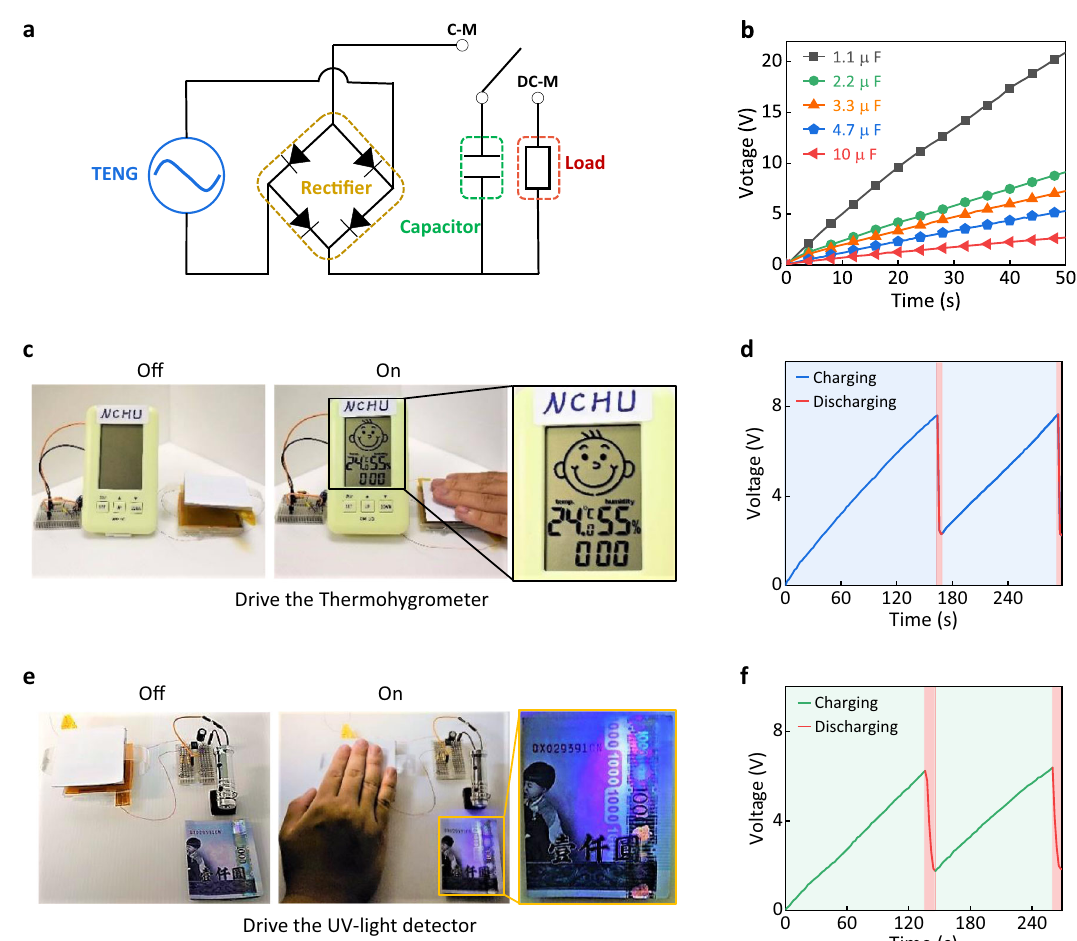
Fig. 5 Demonstration of the TI-TENG power sources. a Equivalent circuit of the TI-TENG-based electric power system by equipping with capacitance and external loads. Note that C-M and DC-M represent the charging and discharging working mode, respectively. b Output voltage signals of the solution- based TI-TENG depending on the equipped capacitance under the charging mode. Schematic illustration of the designed electric power system for driving commercial loads under the discharging working mode, such as driving c a thermohygrometer and e a UV-light detector. d , f The corresponding charging and discharging pro fi les for two cycles. Source data are provided as a Source Data fi